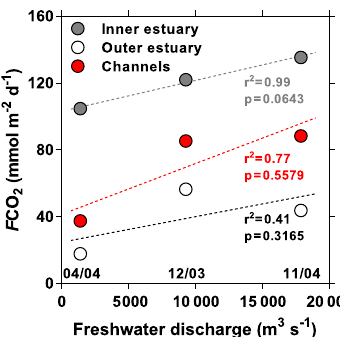
Figure 12. Average air–water CO 2 fluxes ( F CO 2 , mmolm − 2 d − 1 ) in the inner and outer estuaries and side channels of the Mekong delta as a function of freshwater discharge (m 3 s − 1 ) in Decem- ber 2003, April 2004, and October 2004. Sampling dates (mm/yy) are indicated in the bottom of the panel. Dotted lines indicate the linear regression